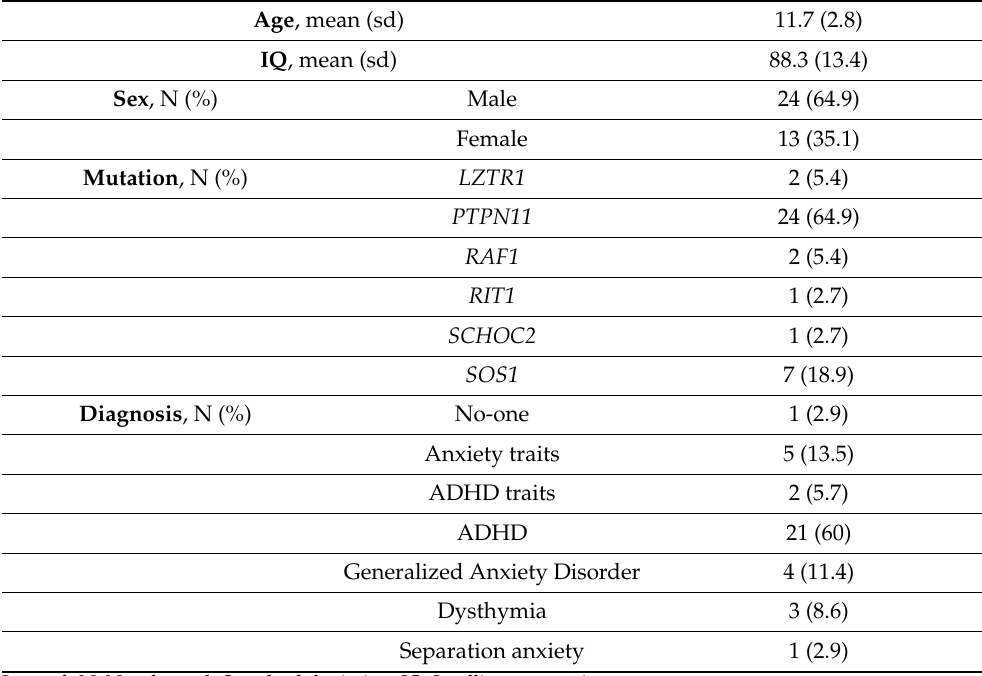
Table 1. Descriptive characteristics of subjects with Noonan